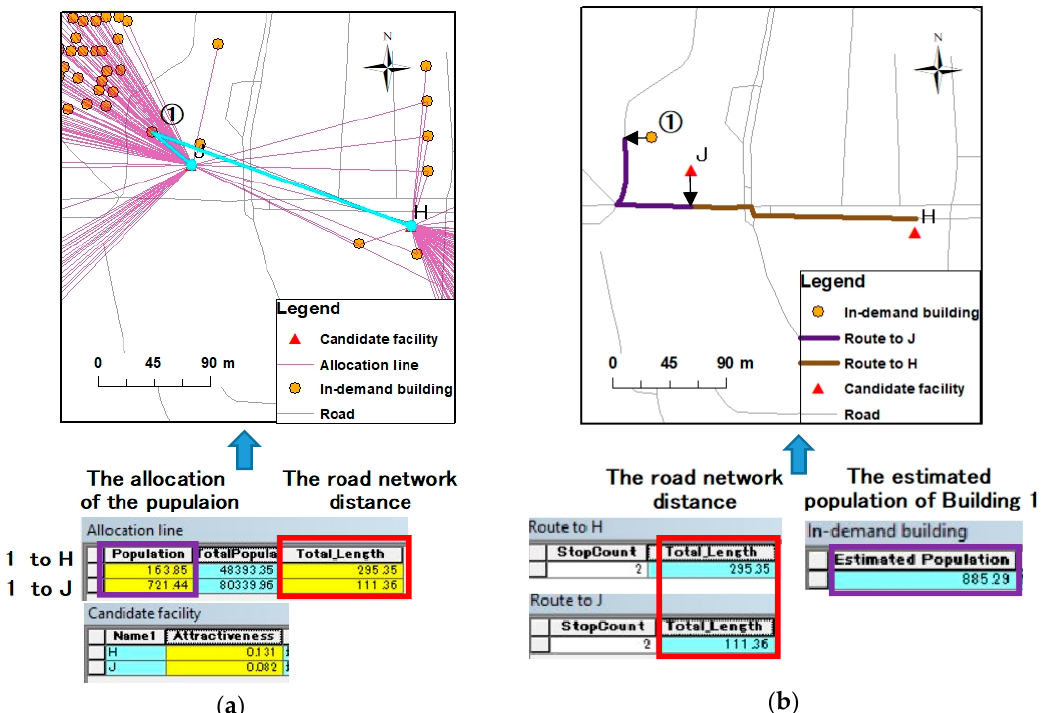
Figure 7. An example used in the calculation. (a) Allocation of PPP within 300 m, and (b) road network route from Building 1 to PPP within 300 m.